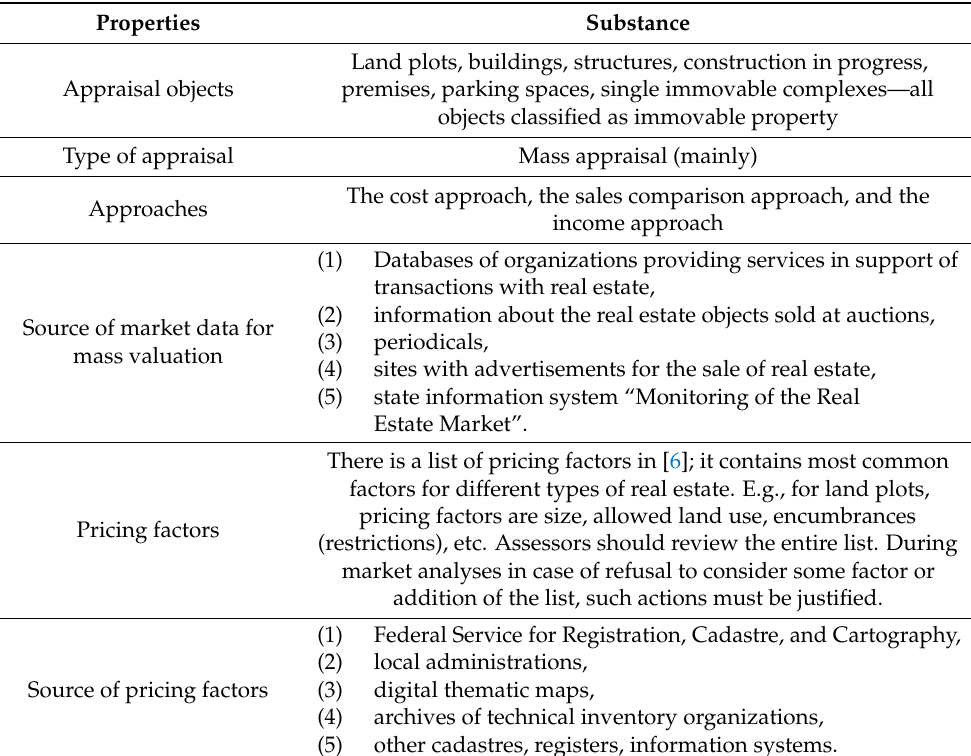
Table 1. Main properties of mass appraisal and cadastral value in